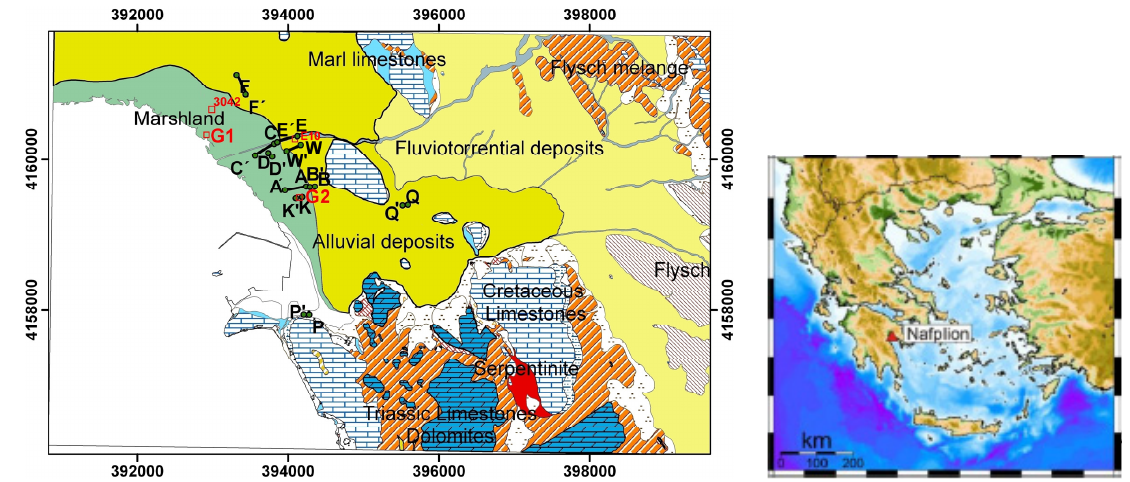
Fig. 1. Geological map of the broader study area (onset: location of Nafplion on the general map of Greece). Locations of boreholes (red open squares) and seismic survey lines (black lines) are also